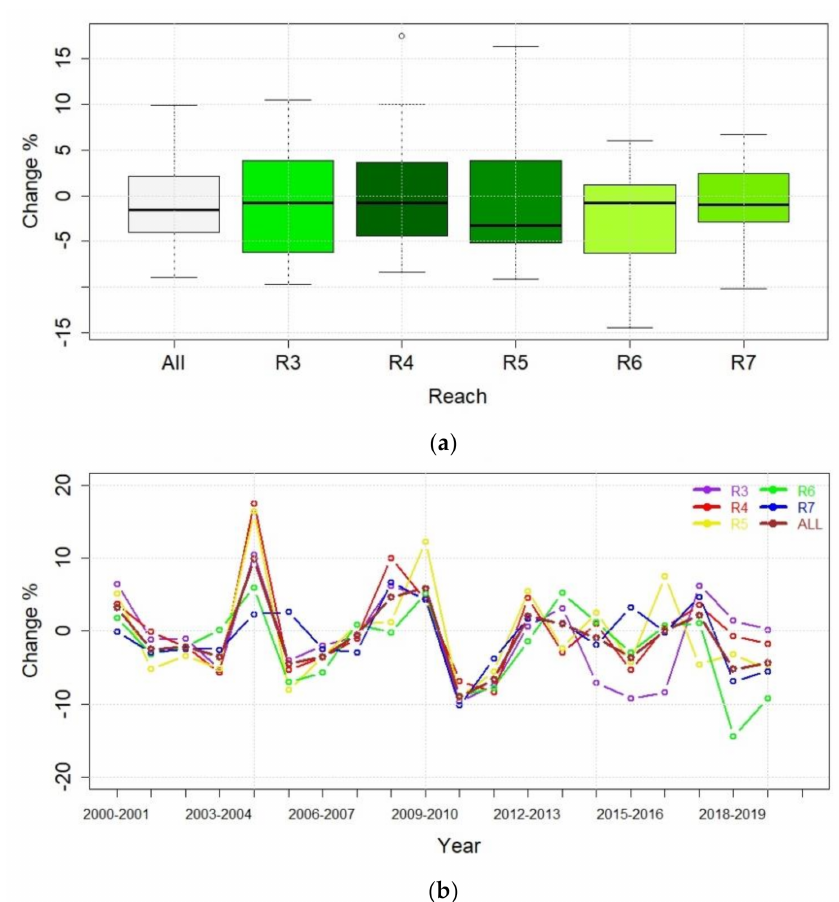
Figure 4. The percent change in EVI2 for the peak growing season for each reach and the entire LCR riparian corridor (All) is shown using plots with a horizontal line, box, and whisker ends that indicate the median, 25th and 75th percentiles, and the 10th and 90th percentiles, respectively, and the data points outside this range are shown by dots ( a ); the rate of change in EVI2 is shown from year-to-year during 2000–2020 and for each reach ( b